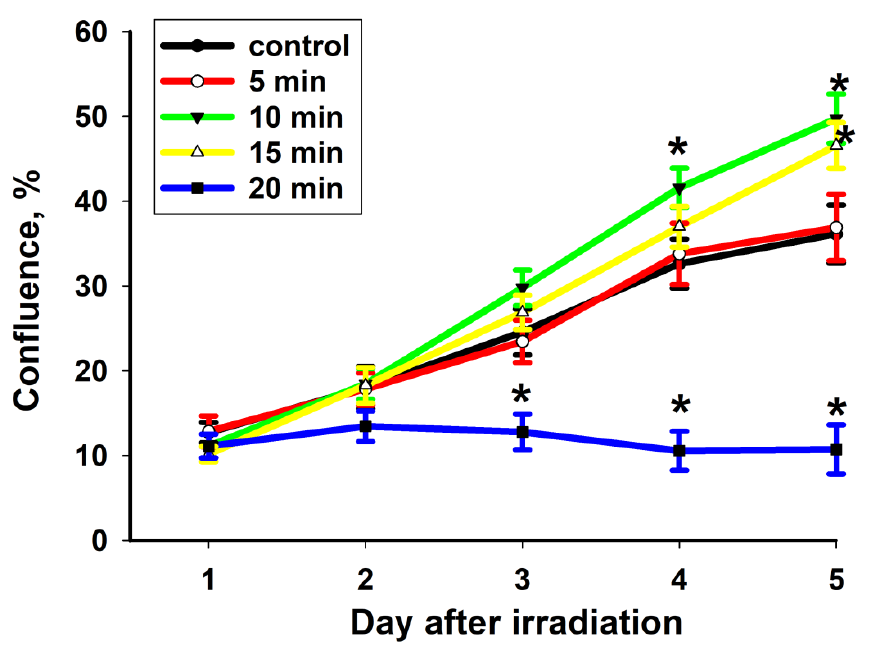
Figure 1. The density-increase dynamics of normal MSC cells after CAAP treatment at different exposure times (5 min, 10 min, 15 min and 20 min) and in the control experiment. * p < 0.001. The CAAP exposure of MNNG/HOS osteosarcoma cells for 5 min did not affect their